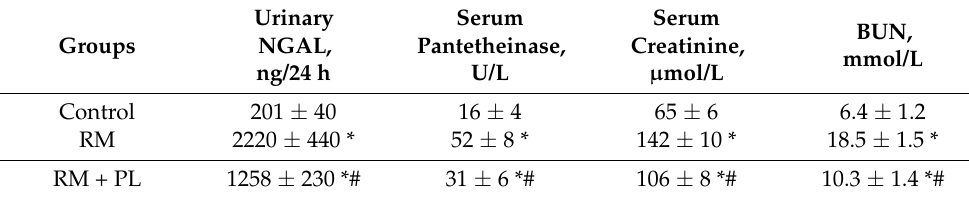
Table 1. Levels of NGAL in urine, activity of pantetheinase and concentration of creatinine and BUN in blood serum of rats at 7 day after rhabdomyolysis and after 7 days of PL administration.